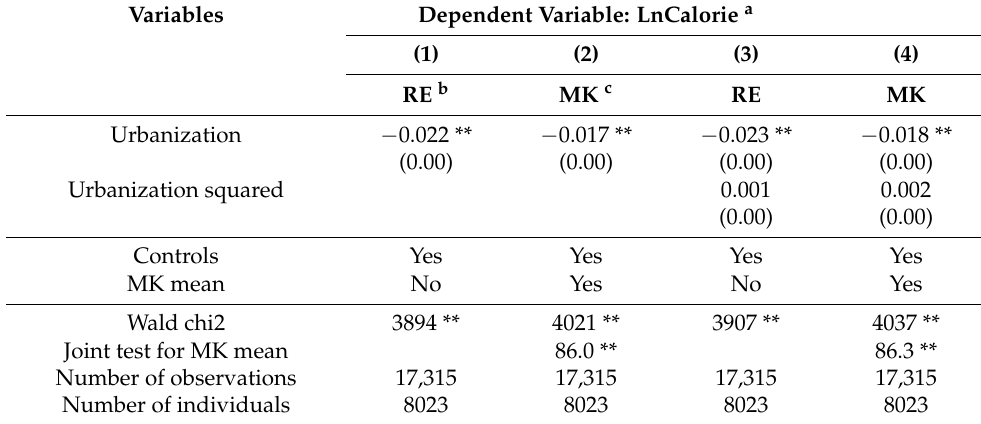
Table 2. The effect of urbanization on calorie